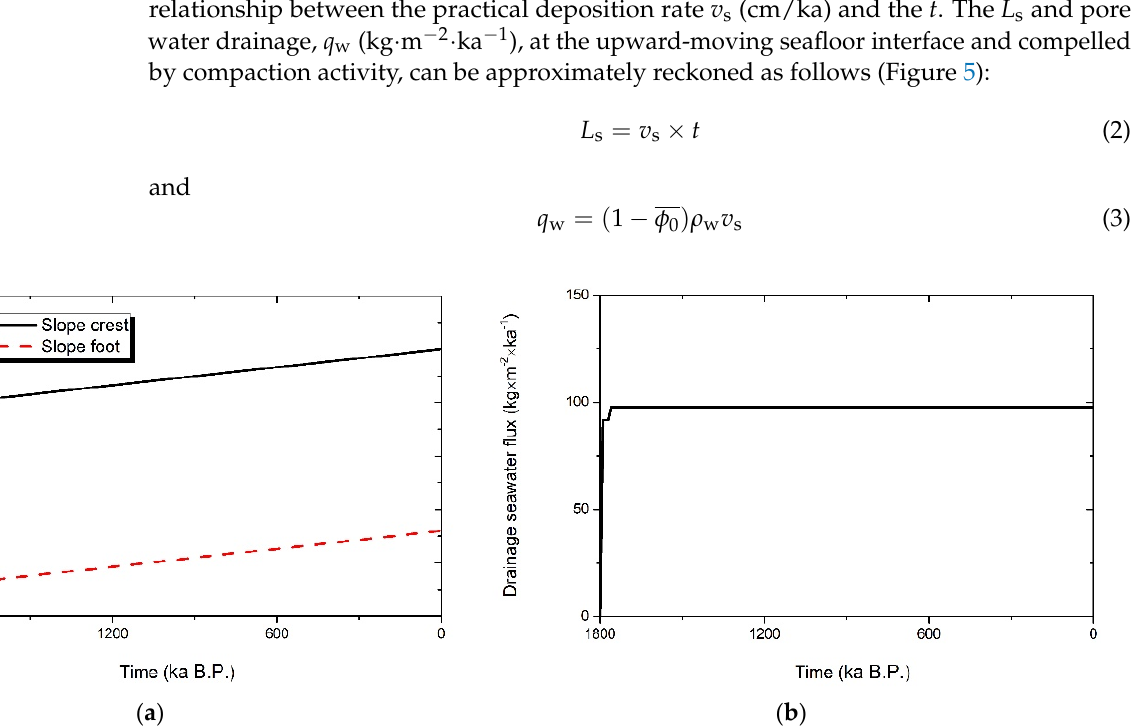
Figure 5. The slope crest and foot position over time since 1.8 Ma ( a ), and corresponding drainage flux ( b ).